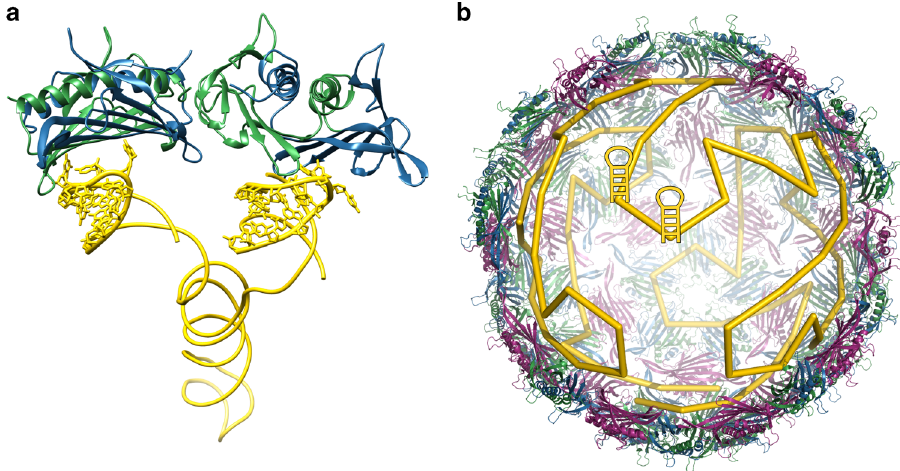
Fig. 1 Hamiltonian path representation of MS2 genome organisation. a Two consecutive PS sites in the linear genomic sequence are mapped on adjacent binding sites in the inner capsid surface. The stem loops (PDB ID: 5TC1) and the backbone connecting them were reported in ref. 2 . The coat protein shell is shown as ribbons based on the icosahedrally averaged X-ray structure (PDB ID: 1ZDH 12 ). b These neighbouring PS contacts are represented by HPA as a short segment of an inscribed path connecting binding sites in the capsid interior, irrespective of their relative distance in the linear genomic RNA and the tertiary structure of the RNA fragment connecting them